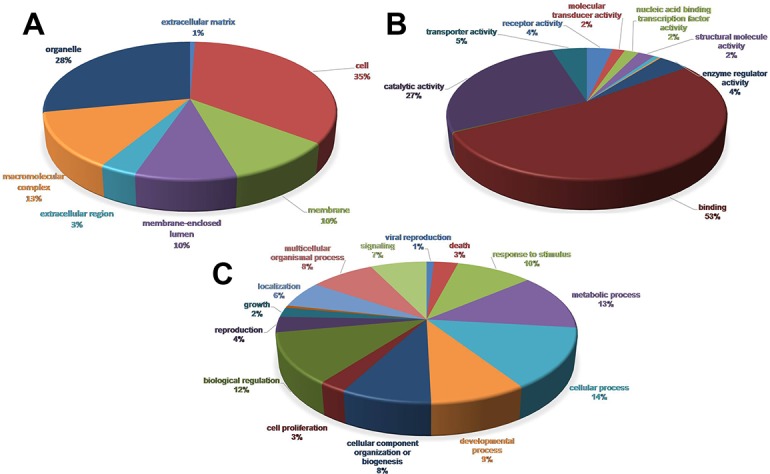
Gene Ontology(GO) analysis of the Crassostrea hongkongensis transcriptome on level 2.The percentage and distribution of top-level GO-terms were portrayed in the three categories: (A) Cellular component; (B) Molecular function and (C) Biological process.